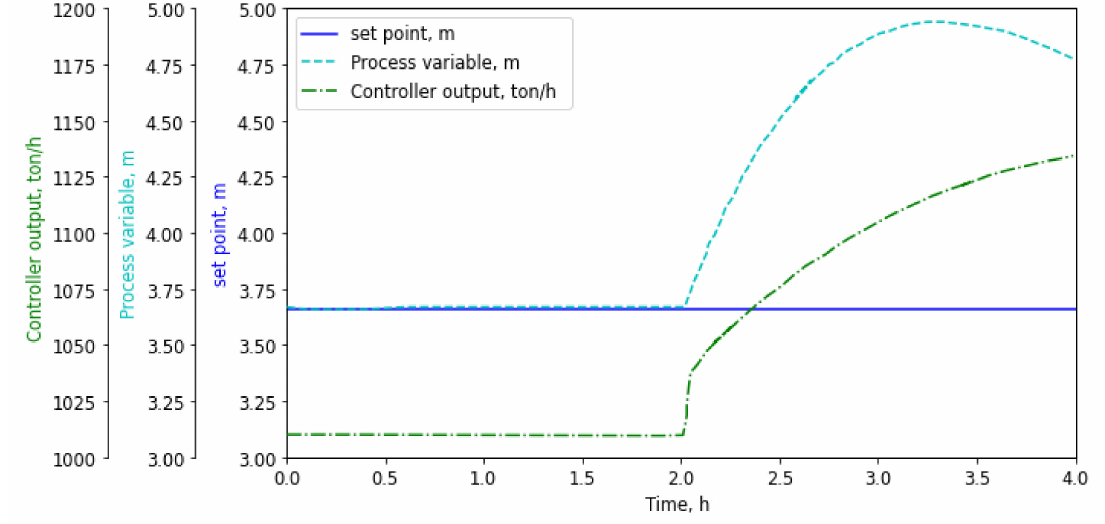
Figure 8. Sump level rising in response to 5% increase in capture